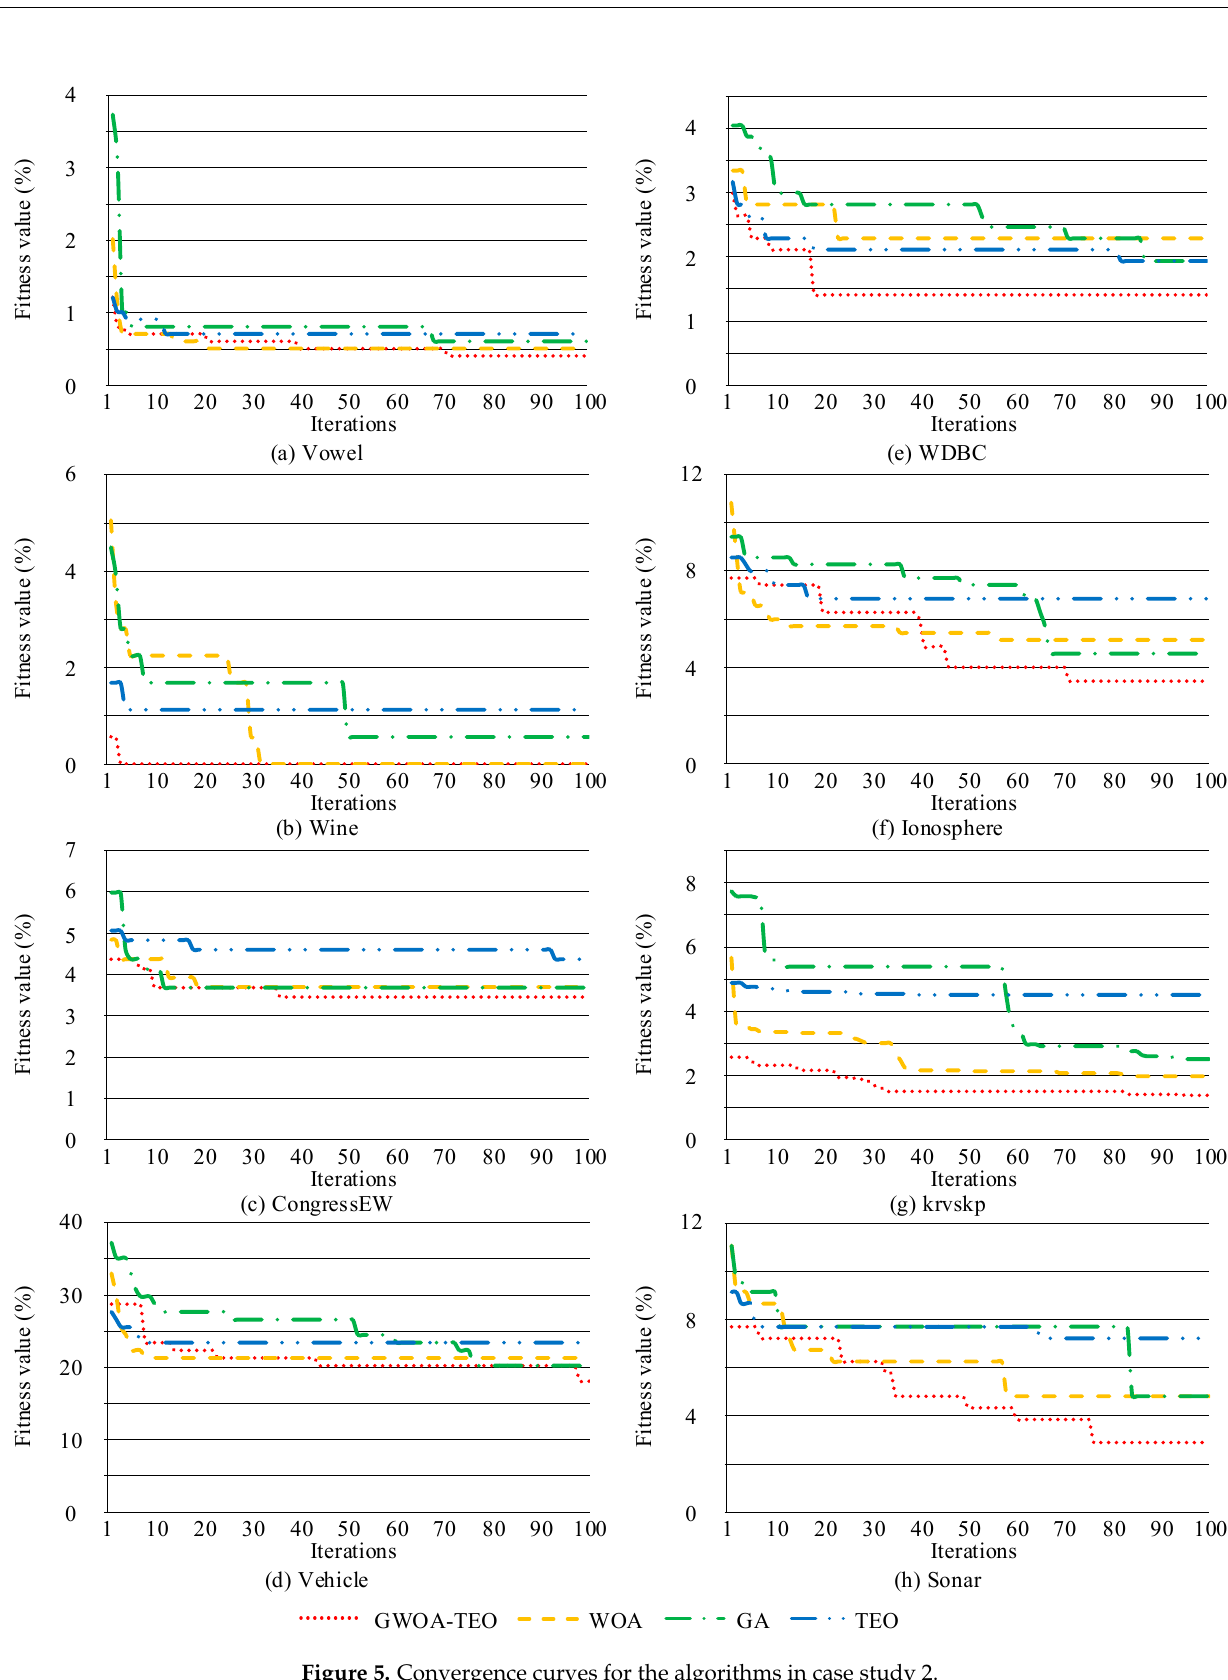
Figure 5. Convergence curves for the algorithms in case study